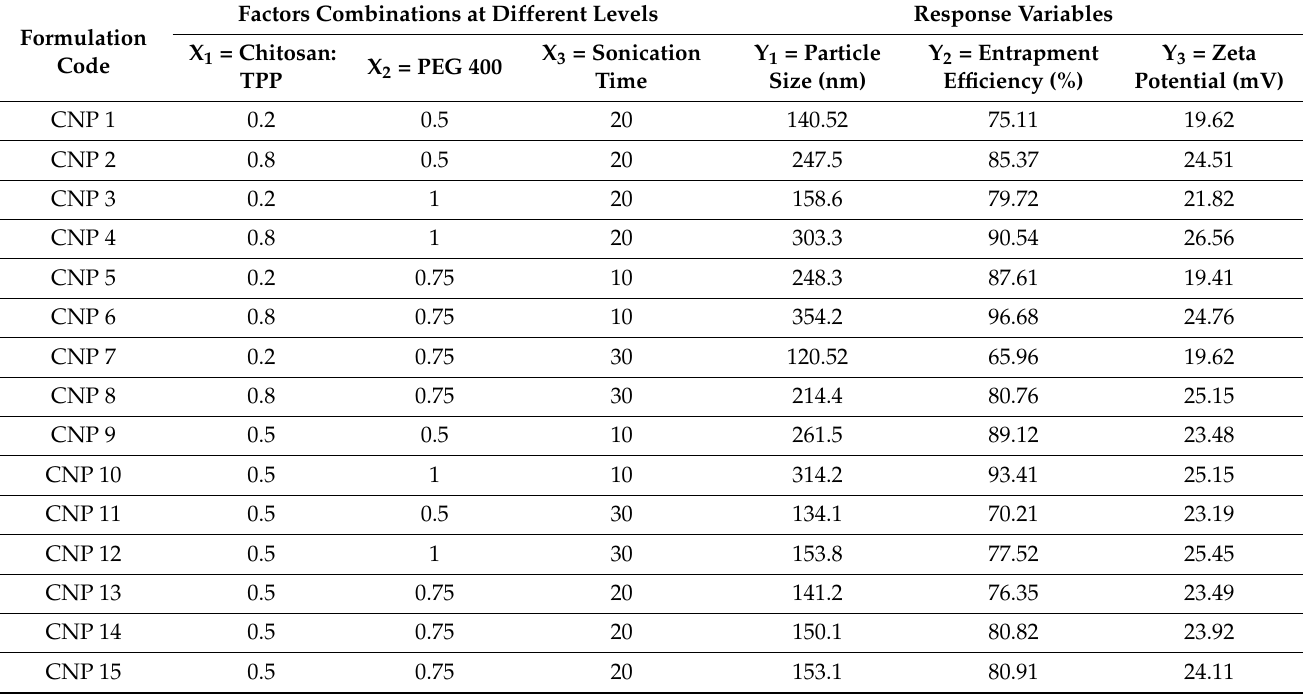
Table 2. Variables and observed responses in